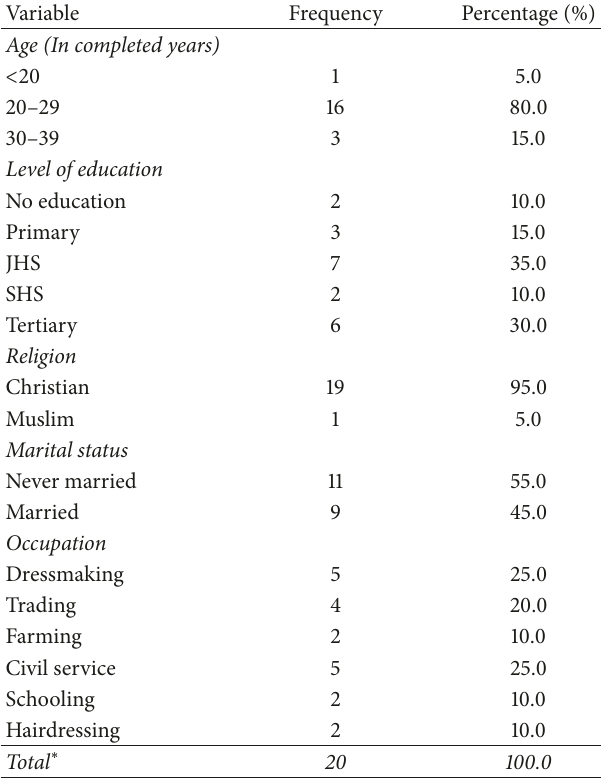
Table 1: Socio-demographic characteristics of